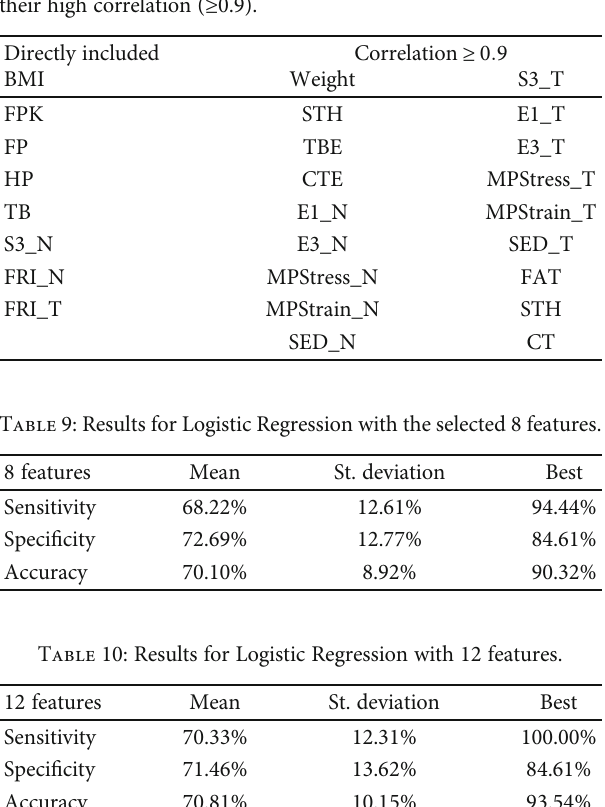
Table 11: Results of SVM with a linear kernel.